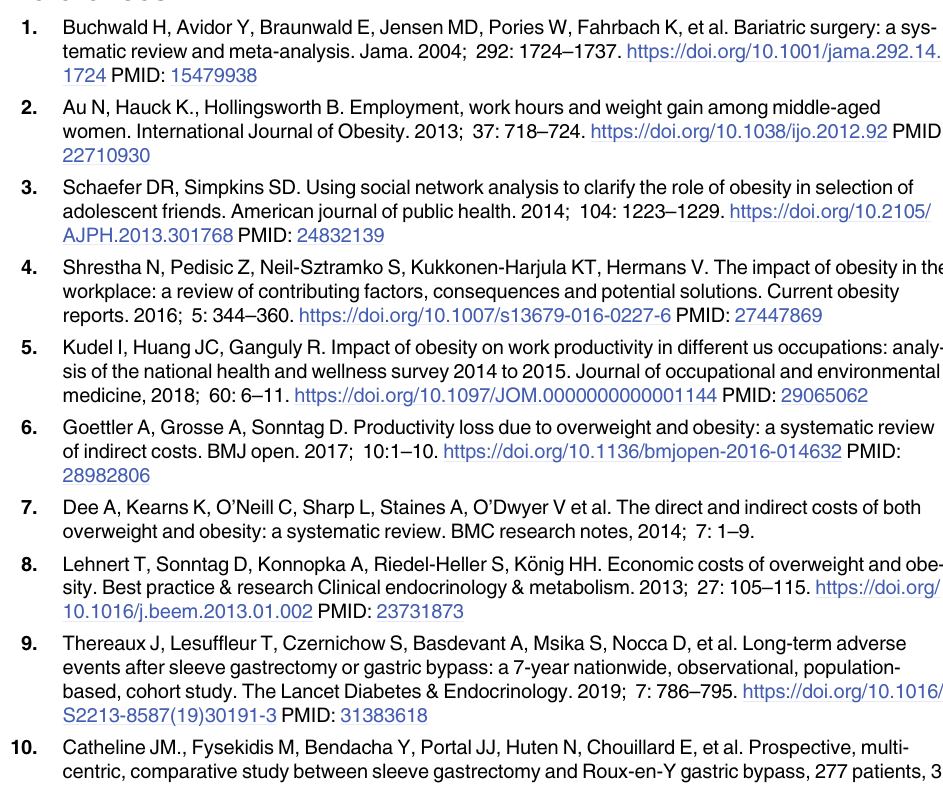
S3 Fig. BAROS questionnaire. (TIF) S4 Fig. Satisfaction scale. What is your degree of satisfaction with bariatric surgery?.